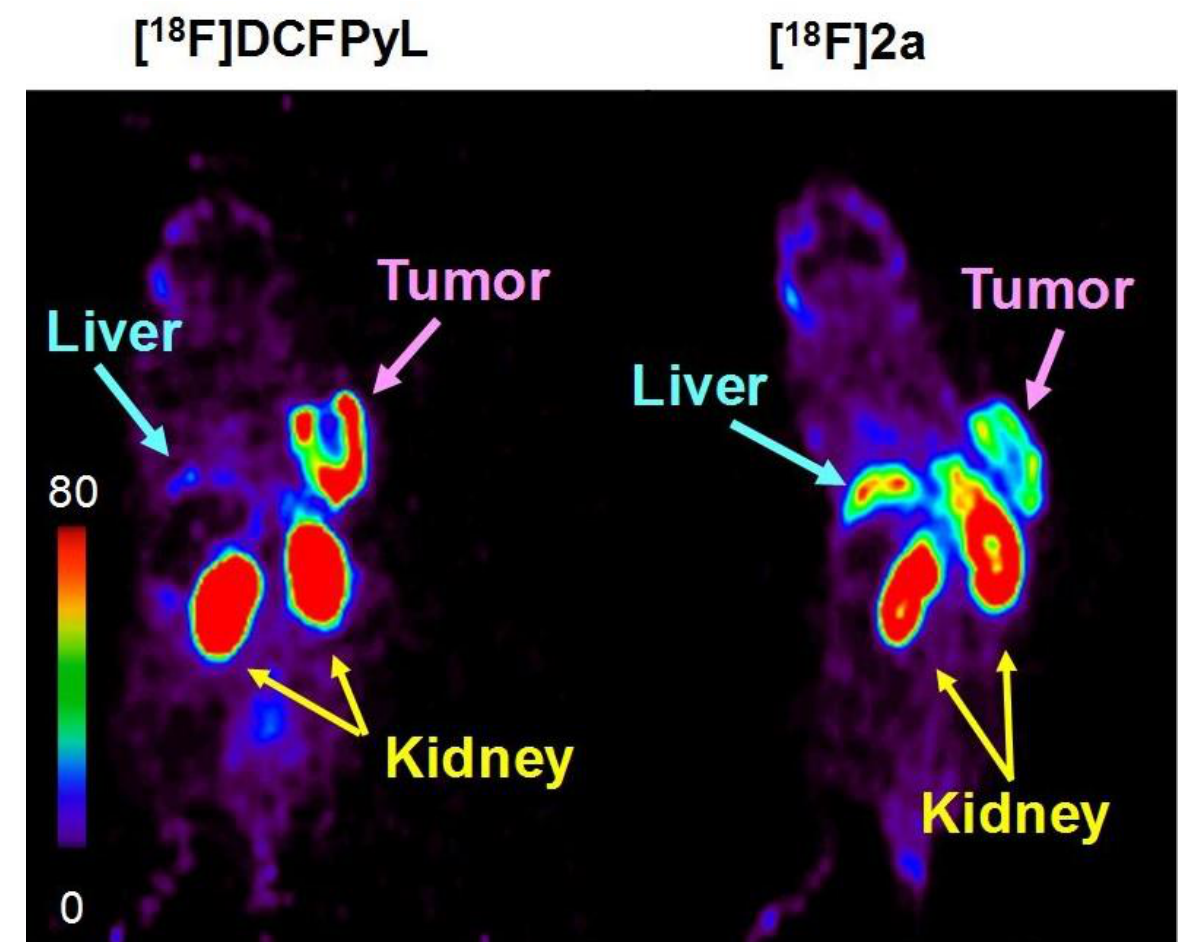
Figure 7. Representative coronal PET images of, PC3(+) tumor xenograft mice at 60 min post-injection of [ 18 F]DCFPyL or [ 18 F] 2a [3.7 – 7.4 MBq (100 – 200 µCi)]. Tumors appear on the right shoulder (pink arrows).